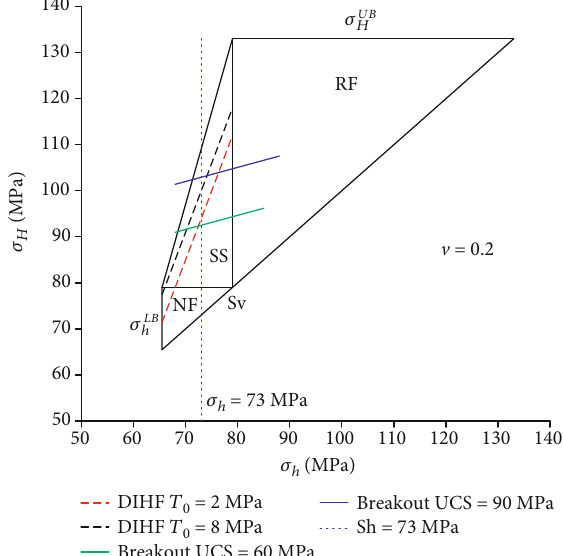
Figure 9: Constrained ranges of the minimum and maximum horizontal stresses obtained from Poisson ’ s ratio-based new stress polygon plot combined drilling-induced tensile fractures and wellbore breakouts in the vertical well shown in Figure 8.